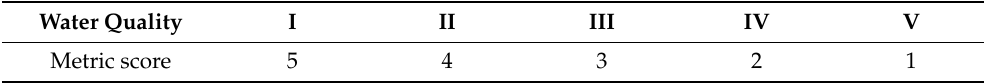
Table 7. Water quality index scores.